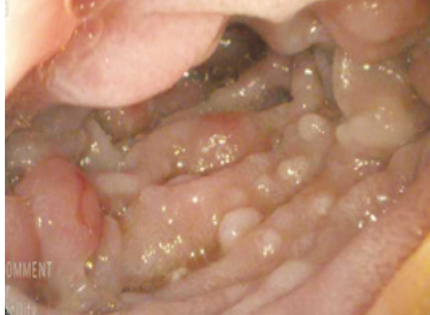
Figure 2: Endoscopic evaluation of the proximal jejunum demon- strating extensive polyposis of the